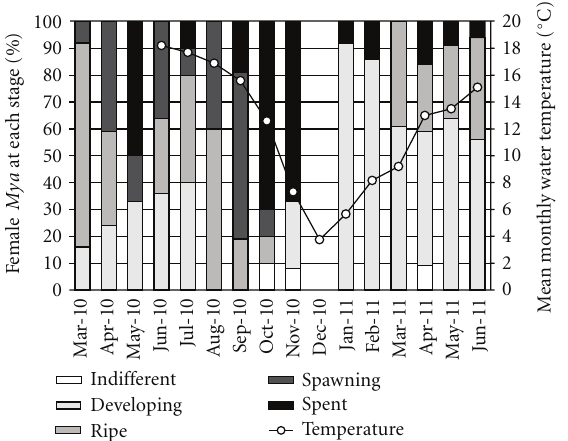
Figure 4: Stages of gametogenesis observed in female clams over the study period.